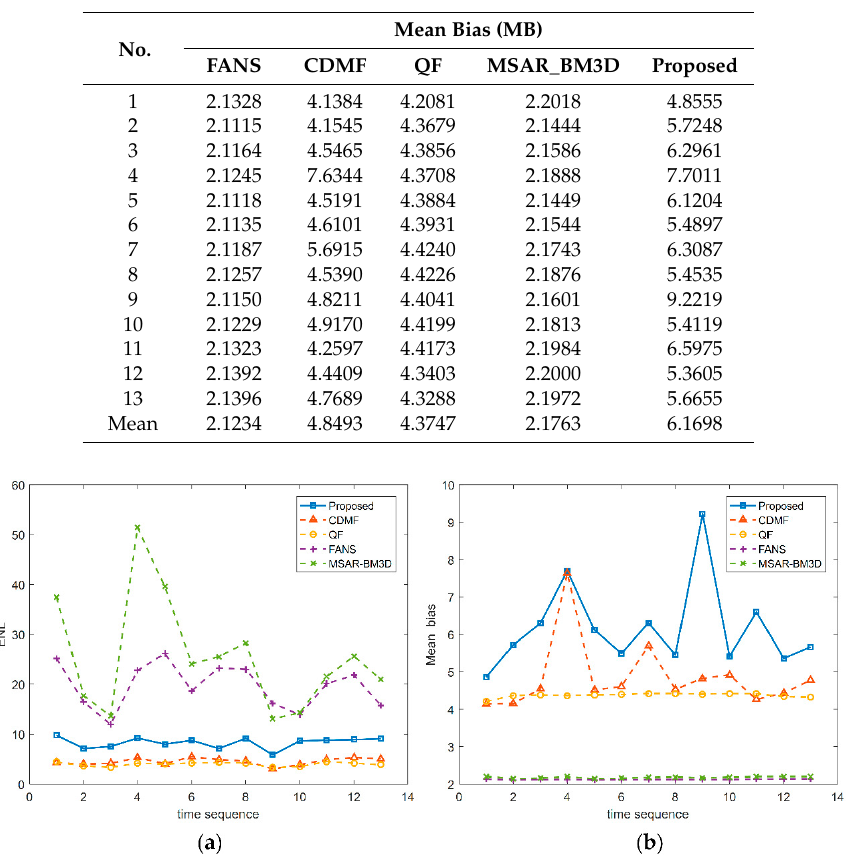
Table 4. The quantitative comparison of different filtering results for Dataset 1, using mean bias (MB).